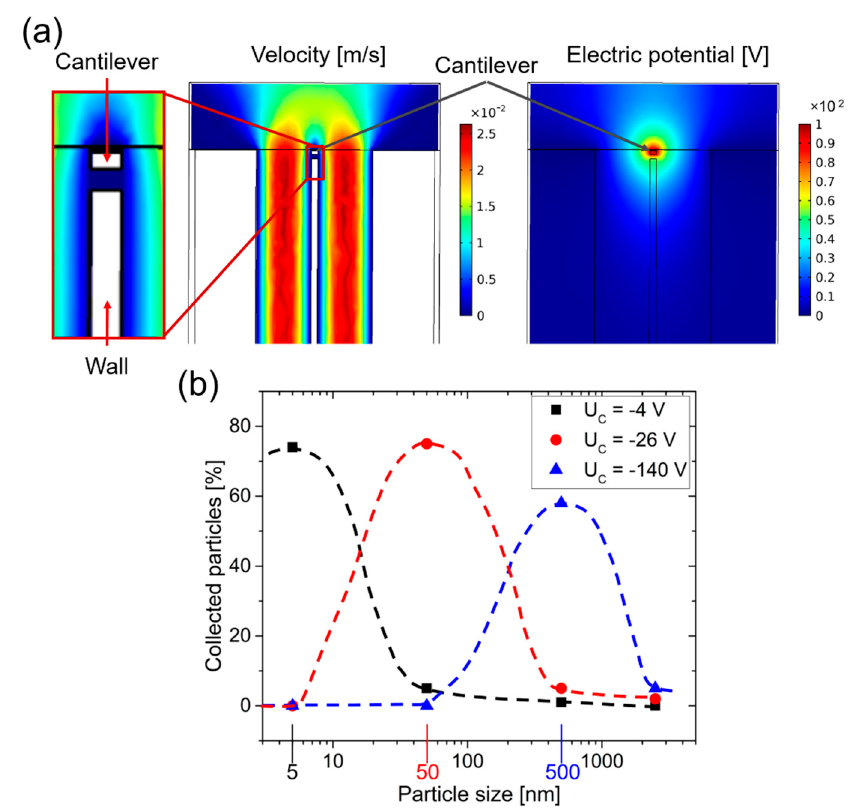
Figure 9. COMSOL simulation results of NP tracing in a micro channel (80 × 50 µ m 2 , side view) showing ( a ) the flow velocity, ( b ) particles with 10 nm in diameter, and ( c ) particles with 2.5 µ m in diameter. The colors represent the velocity (in m/s) of the air flow and of the particles. A pressure difference of 1 Pa and a negative electric potential of − 100 V were applied to the collecting electrode on the cantilever.